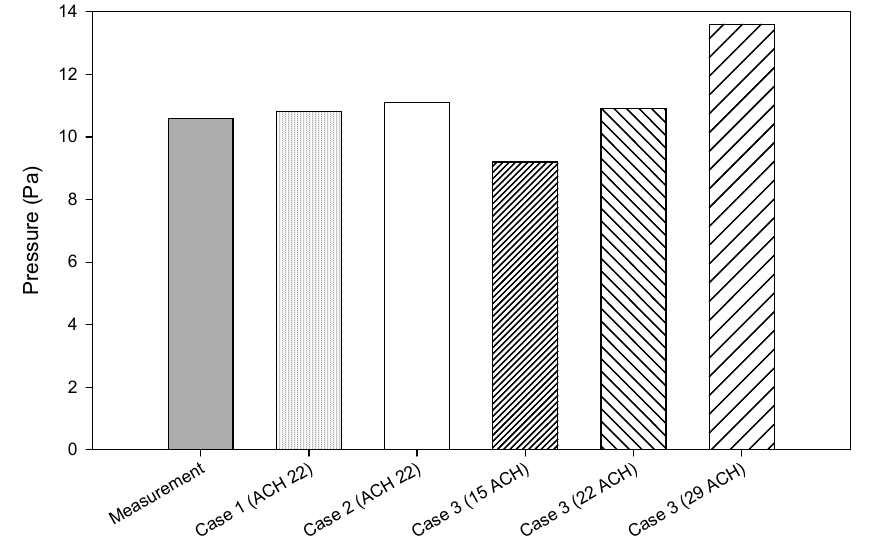
Figure 10. Pressurization effect with different schemes.